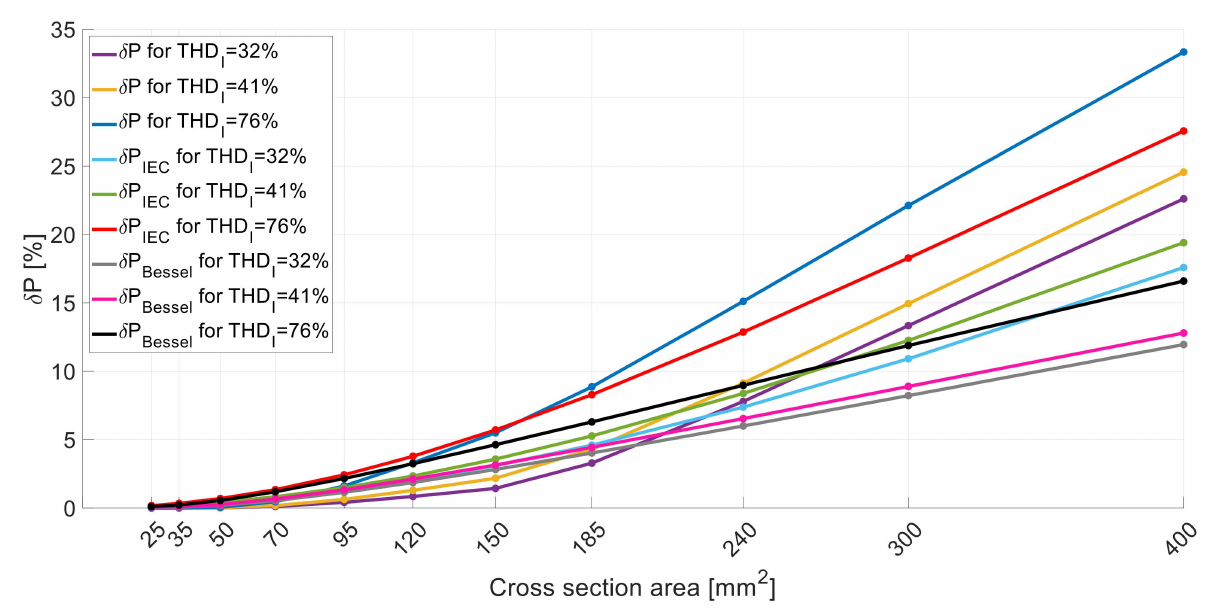
Figure 8. The percentage increments of active power losses calculated for the distorted currents in comparison to the active power losses of the fundamental